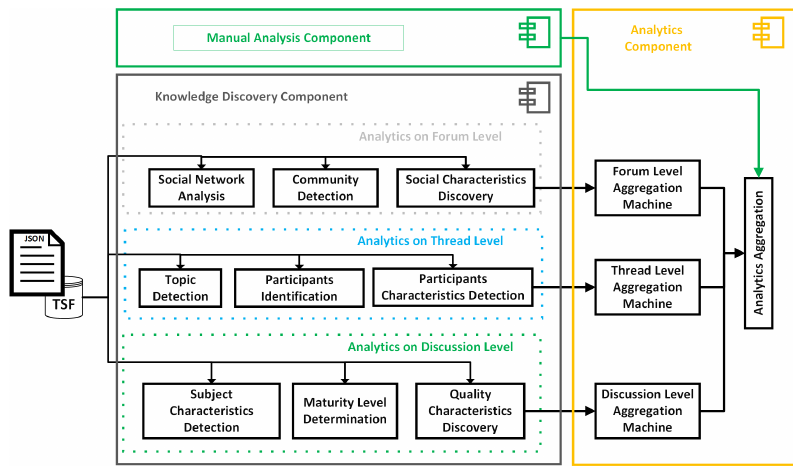
Figure 7. SECDFAN Analytic Layer